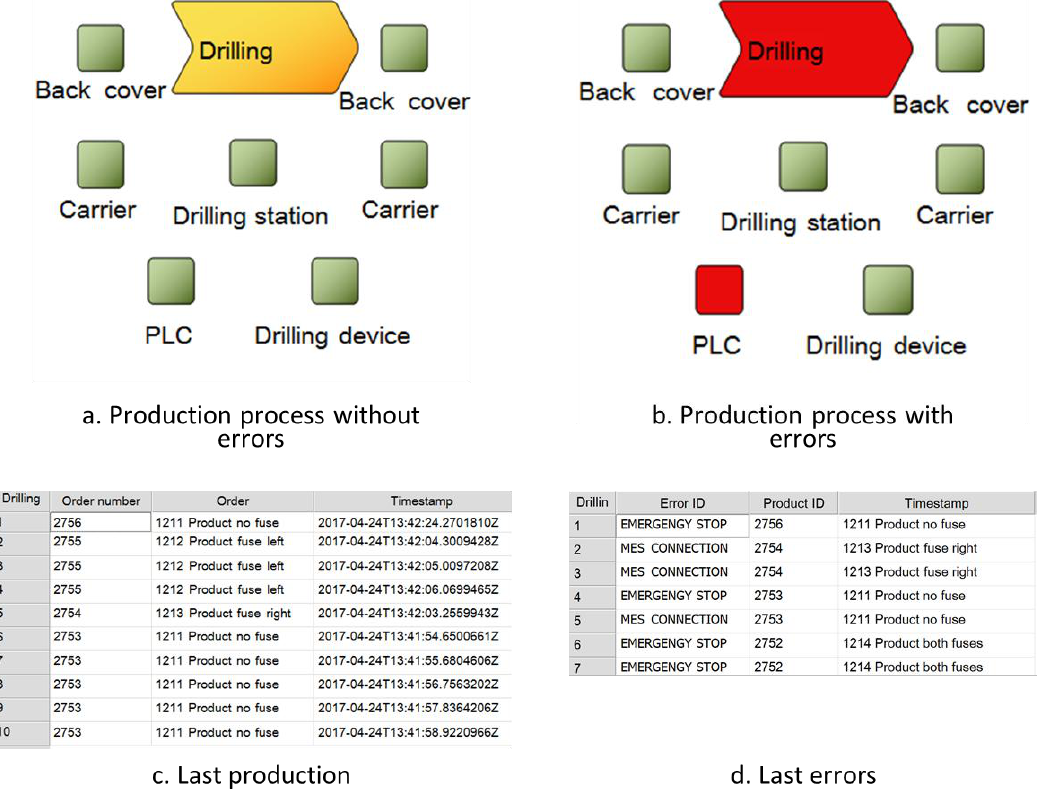
Figure 13. Drilling activity in the process